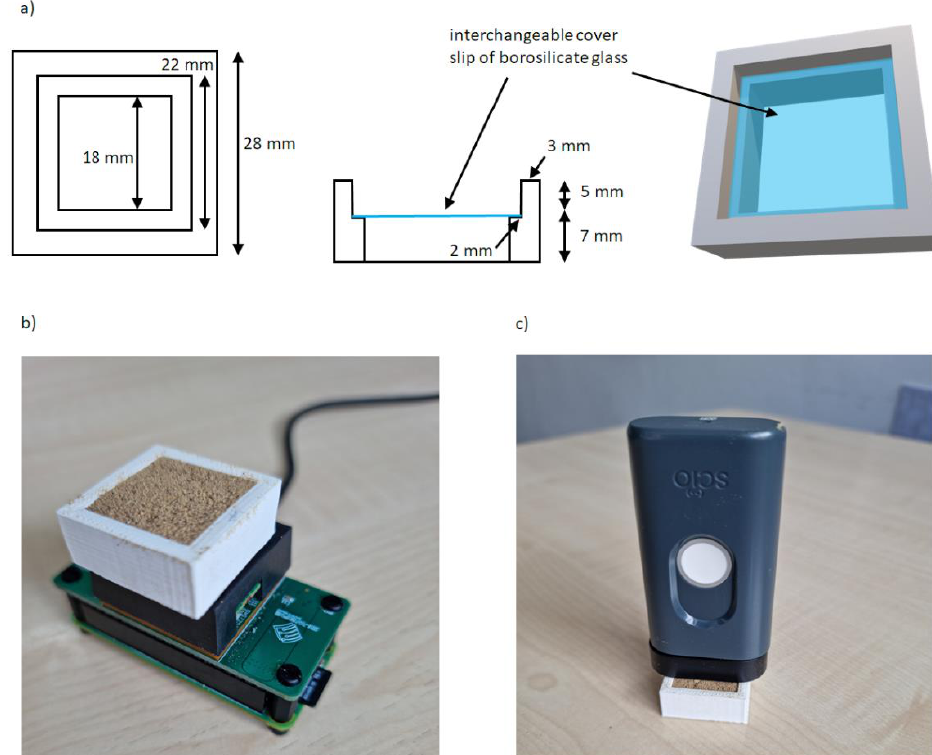
Figure 1. a ) homemade cell for the NeoSpectra MDK and SCiO NIR devices, b ) experimental con- Figure 1. ( a ) homemade cell for the NeoSpectra MDK and SCiO NIR devices, ( b ) experimental figuration using the homemade cell for the NeoSpectra MDK measurements, c ) experimental con- configuration using the homemade cell for the NeoSpectra MDK measurements, ( c ) experimental figuration using the homemade cell for the SCiO measurements. configuration using the homemade cell for the SCiO